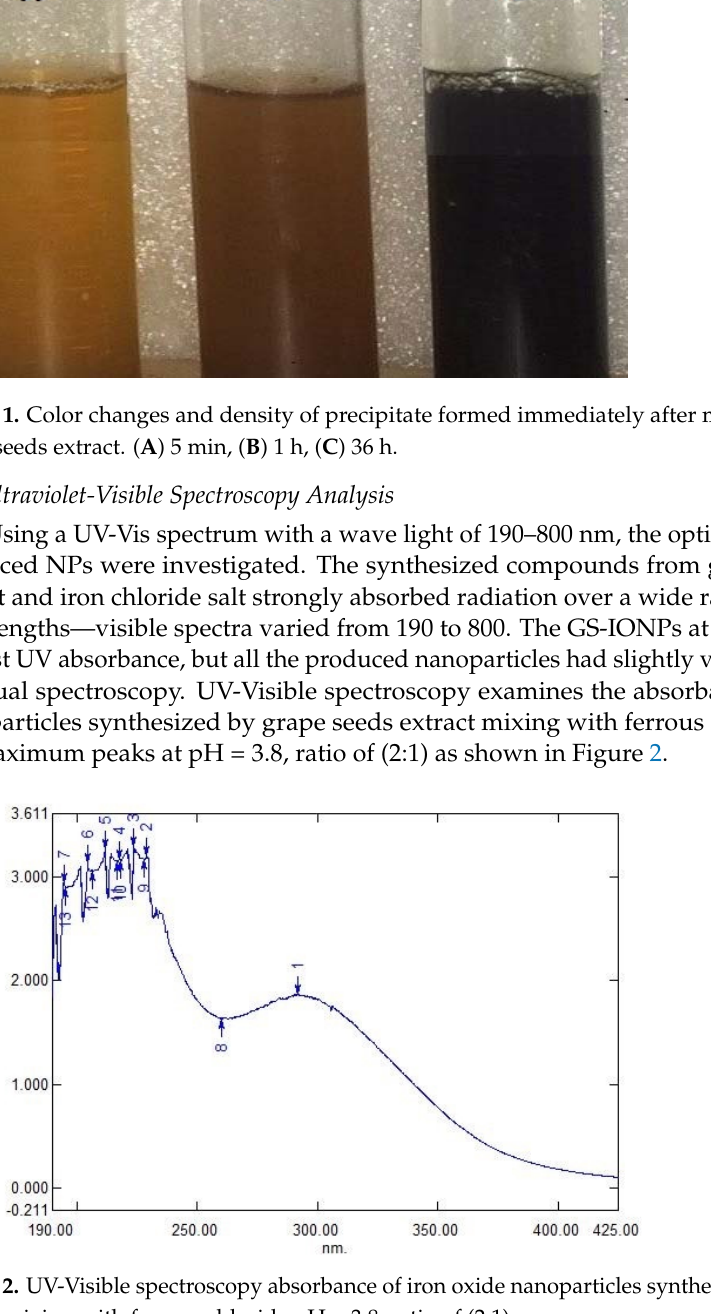
Figure 2. UV-Visible spectroscopy absorbance of iron oxide nanoparticles synthesized by grape extract mixing with ferrous chloride pH = 3.8, ratio of seeds extract mixing with ferrous chloride pH = 3.8, ratio of (2:1).